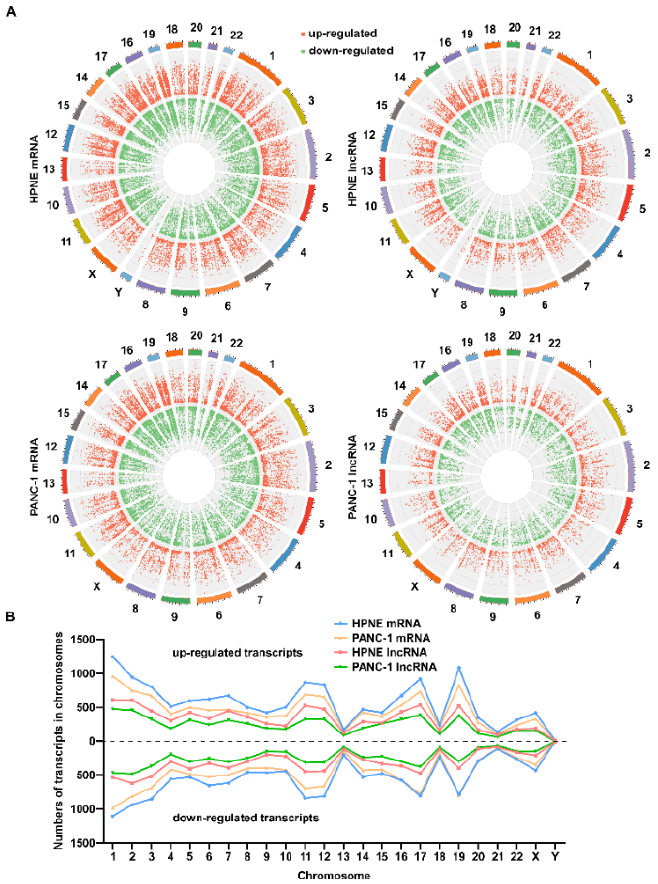
Figure 7. Chromosomal distribution of the differentially expressed transcripts in HPNE and PANC-1 cells treated with H 2 O 2 . ( A ) The chromosomal distribution of differentially expressed mRNA ( left ) and lncRNA ( right ) transcripts upon H 2 O 2 treatment. Data are shown as Circos diagrams. The red dots represent upregulated transcripts, while the green dots represent downregulated transcripts. Relative height represents log 2 (fold change). ( B ) Numbers of differentially expressed mRNA and lncRNA transcripts in the indicated chromosomes of HPNE and PANC-1 cells treated with H 2 O 2 . The dots below the dotted line represent the downregulated transcripts, while the top dots represent the upregulated